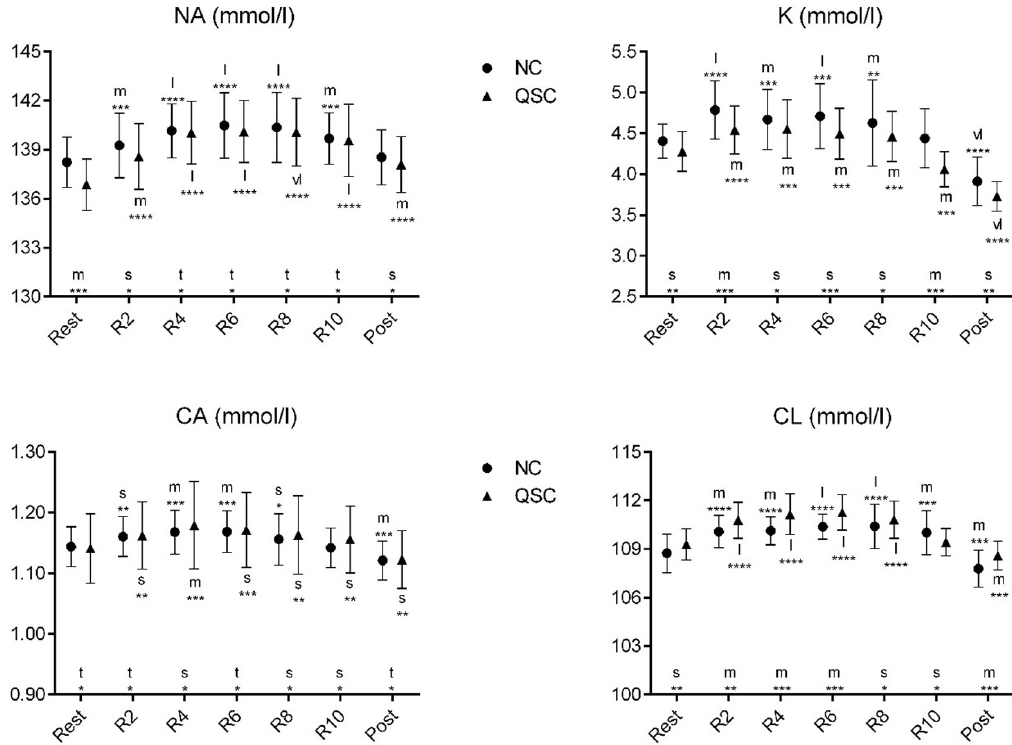
Fig 4. Change in the means of electrolytes-related variables in each repetition in NC and QSC. Error bars are 90% compatibility intervals. Letters stand for the magnitude of the mean changes as following: t = trivial; s = small; m = moderate; l = large; vl = very large. Asterisks indicate the likelihood for the magnitude of the true effect as follows: � possible; �� likely; ��� very likely; ���� most likely. Letters and asterisks next to the x-axis indicate the magnitude and uncertainty of the mean changes from NC to the QSC. Letters and asterisks above and below the error bars indicate the magnitude and uncertainty of the mean changes from the rest status to the 2 nd to 10 th repetition and post-test status in NC and QSC. Effects are unclear in the situations without letters or